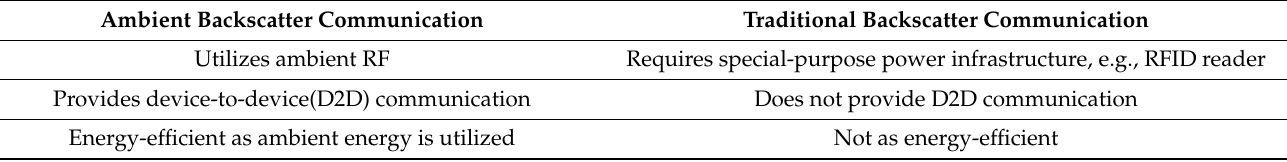
Table 13. Differences between traditional backscatter and ambient backscatter communication systems. Ambient Backscatter Communication Traditional Backscatter Communication Utilizes ambient RF Requires special-purpose power infrastructure, e.g., RFID reader Provides device-to-device(D2D) communication Does not provide D2D communication Energy-efficient as ambient energy is utilized Not as